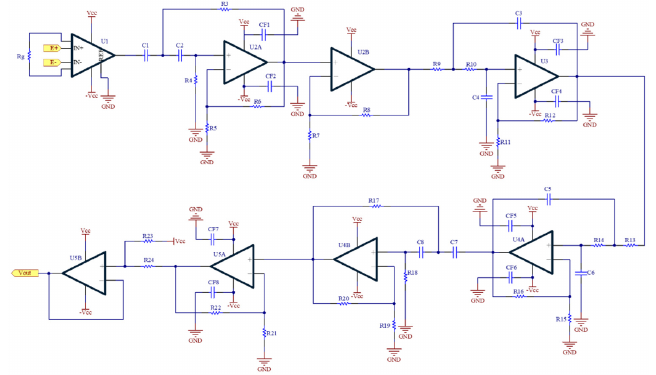
Figure 2. The circuit schematic for BCG measurement.